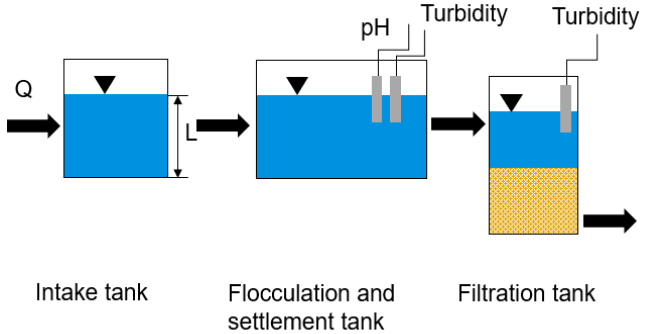
Figure 1. Schematic of a pilot-scale water treatment plant. Table 1. Observed water quality at each reactor in the pilot-scale water treatment plant.